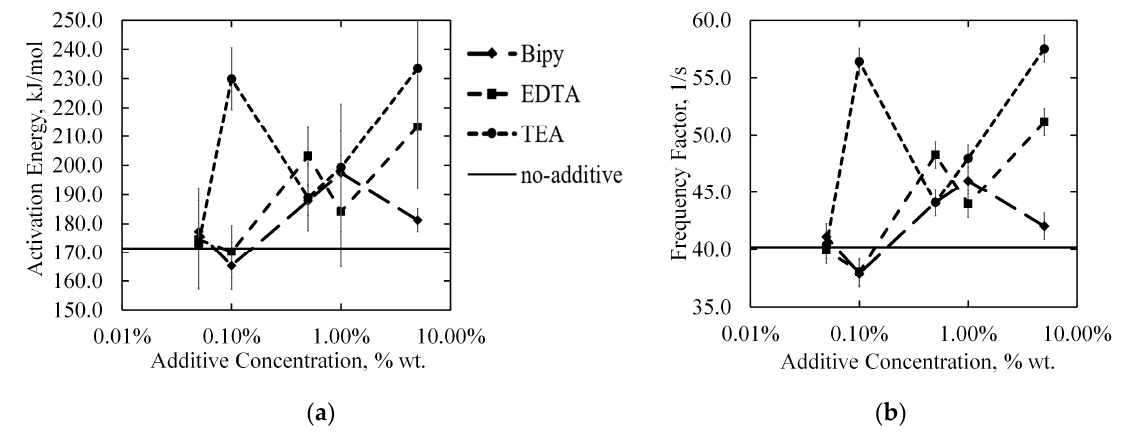
Figure 9. Parameters for the Arrhenius reaction rate calculated from dynamic TGA using Ozawa/Flynn/Wall method. ( a ) Activation energy in kJ/mol with error; ( b ) Natural logarithm of Frequency factor/pre-exponential in s − 1 parameter with error.